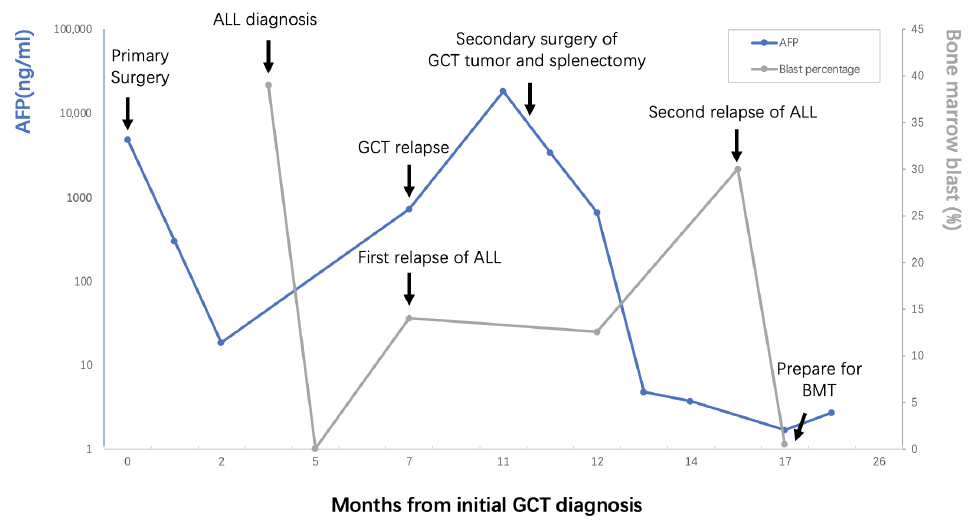
Figure 3. Brief clinical course of the patient’s history, diagnostic process, management and out- comes.